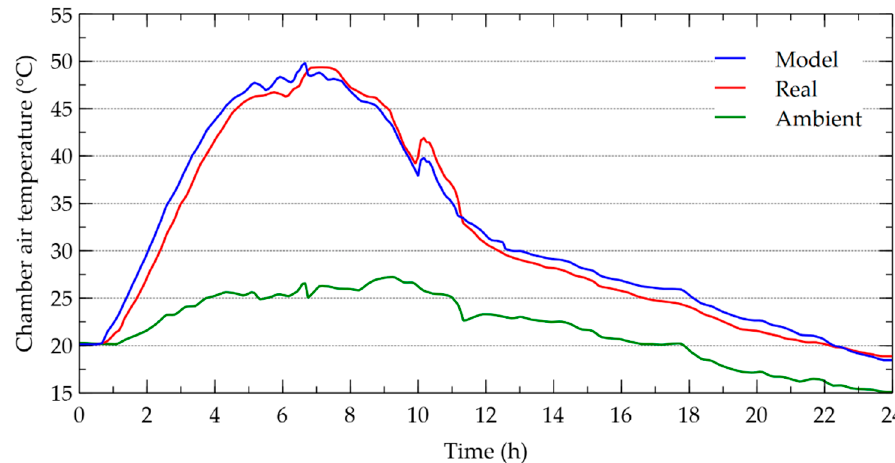
Figure 6. Estimated outlet air temperature with PCM.